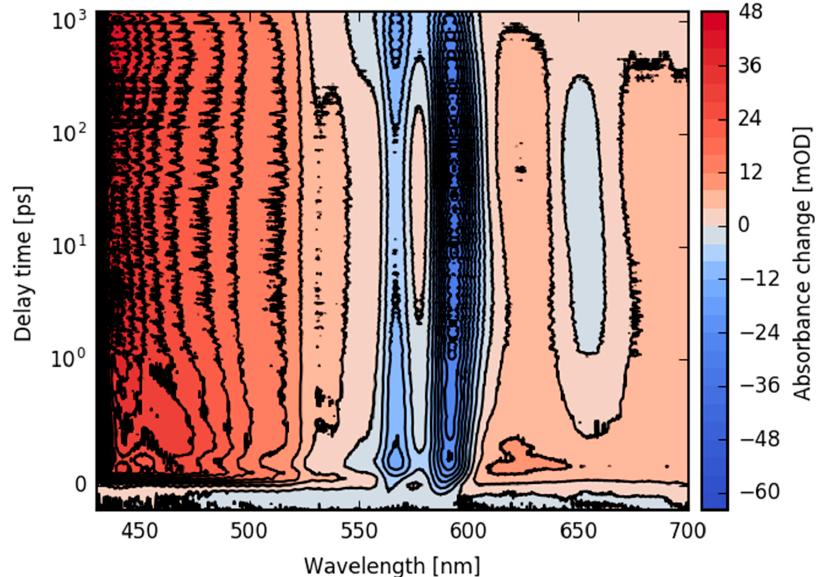
Figure 5. Contour plot of the absorption change upon excitation at 400 nm as a function of wavelength and of delay time from fs to 1.2 ns. The change in absorption is color-coded. and of delay time from fs to 1.2 ns. The change in absorption is